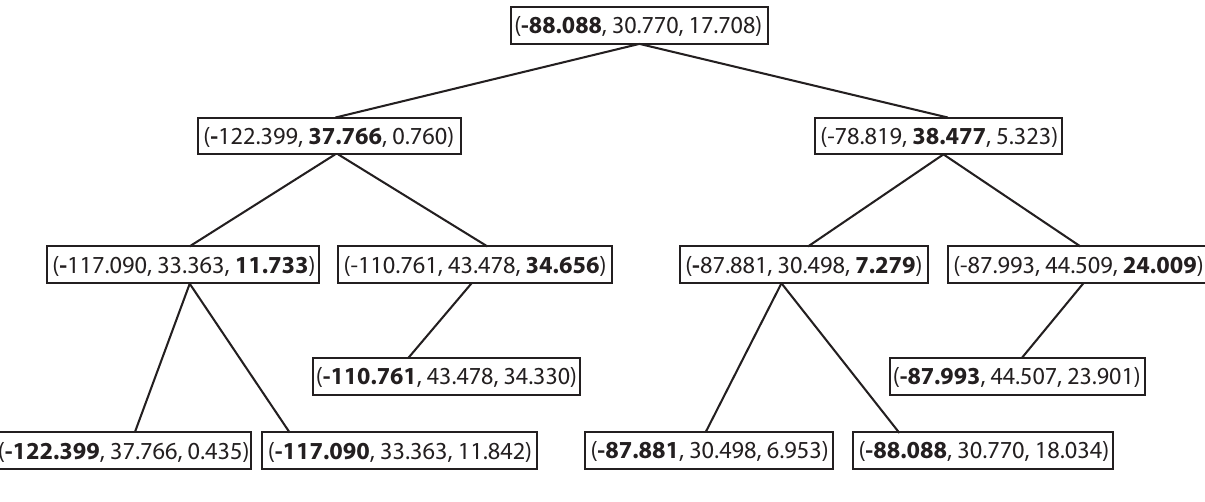
Figure 7. A sample k-d tree constructed from some selected PM